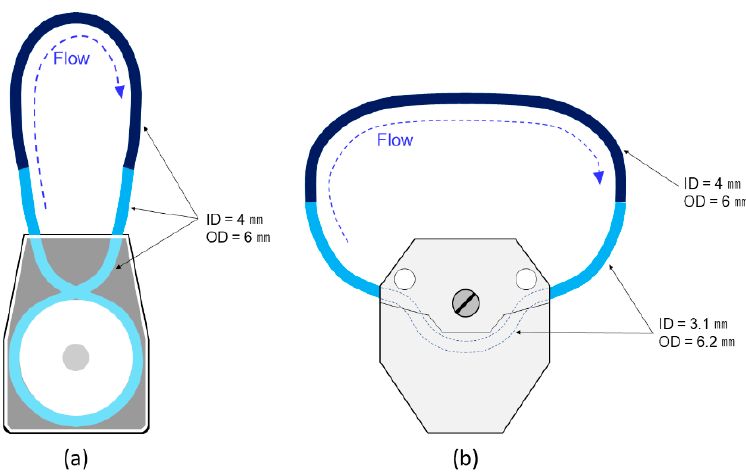
Figure 4. Schematic illustrations of the cell suspension sending systems for the l-FRP, the l-MRP and the PP. The circulation paths of the systems were structured with silicon tubes. ( a ) The silicon tubes used for the l-FRP and l-MRP had ID of 4 mm and OD of 6 mm. The total length of the two paths was 30 cm and the total liquid volume was about 3.8 mL. ( b ) The silicon tubes used for the peristaltic pump had ID of 4 mm and OD of 6 mm (length: 15 cm), and ID of 3.1 mm and OD of 6.2 mm (length: 30.5 cm). The total liquid volume of the two paths was about 4.2 mL.